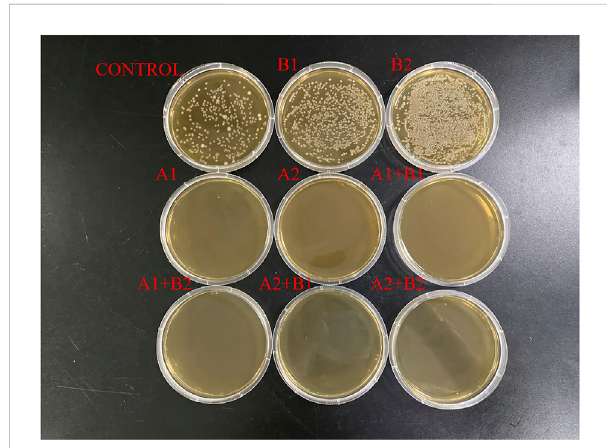
FIGURE 6 In-vitro culture of gut microbiota of largemouth bass. CONTROL: control; B1: low concentration of berberine; B2: high concentration of berberine; A1: low concentration of mixed antibiotics; A2: high concentration of mixed antibiotics.